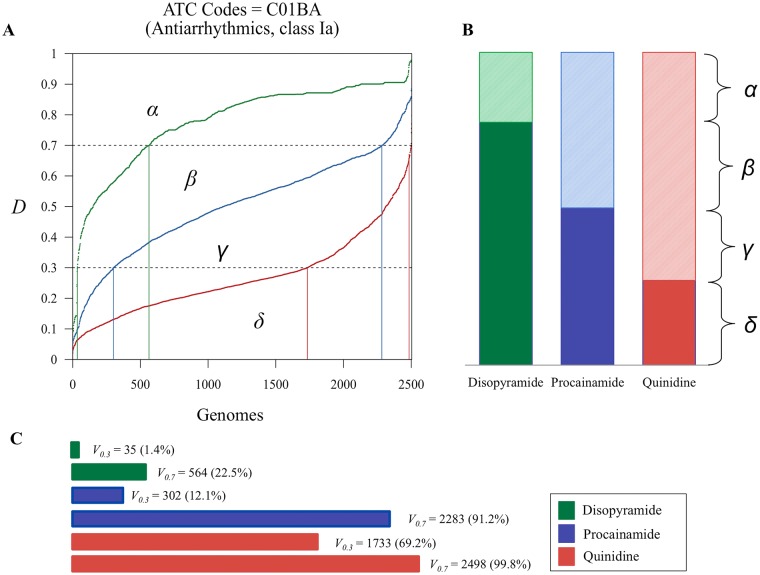
Proposed measures of drug safety to prevent precautions and drug withdrawals from the market.(A) Drug deleteriousness scores for three drugs with the same ATC code (C01BA for antiarrythmics class Ia) [disopyramide (green), procainamide (blue), and quinidine (red)] were computed for 2504 genomes from the 1000 Genomes Project and sorted in the ascending order. (B) The AUC and 1-AUC values represent population deleteriousness and genomic variability of drug-related genes, respectively. (C) When the risk threshold is set at 0.3, 35 (1.4%), 302 (12.1%), and 1733 (69.2%) individuals of the 2504 can be classified as genetically vulnerable to side effects of disopyramide, procainamide, and, quinidine respectively (V0.3). Abbreviations: AUC, area under the drug deleteriousness score curve; ATC, Anatomical Therapeutic Chemical Classification System.